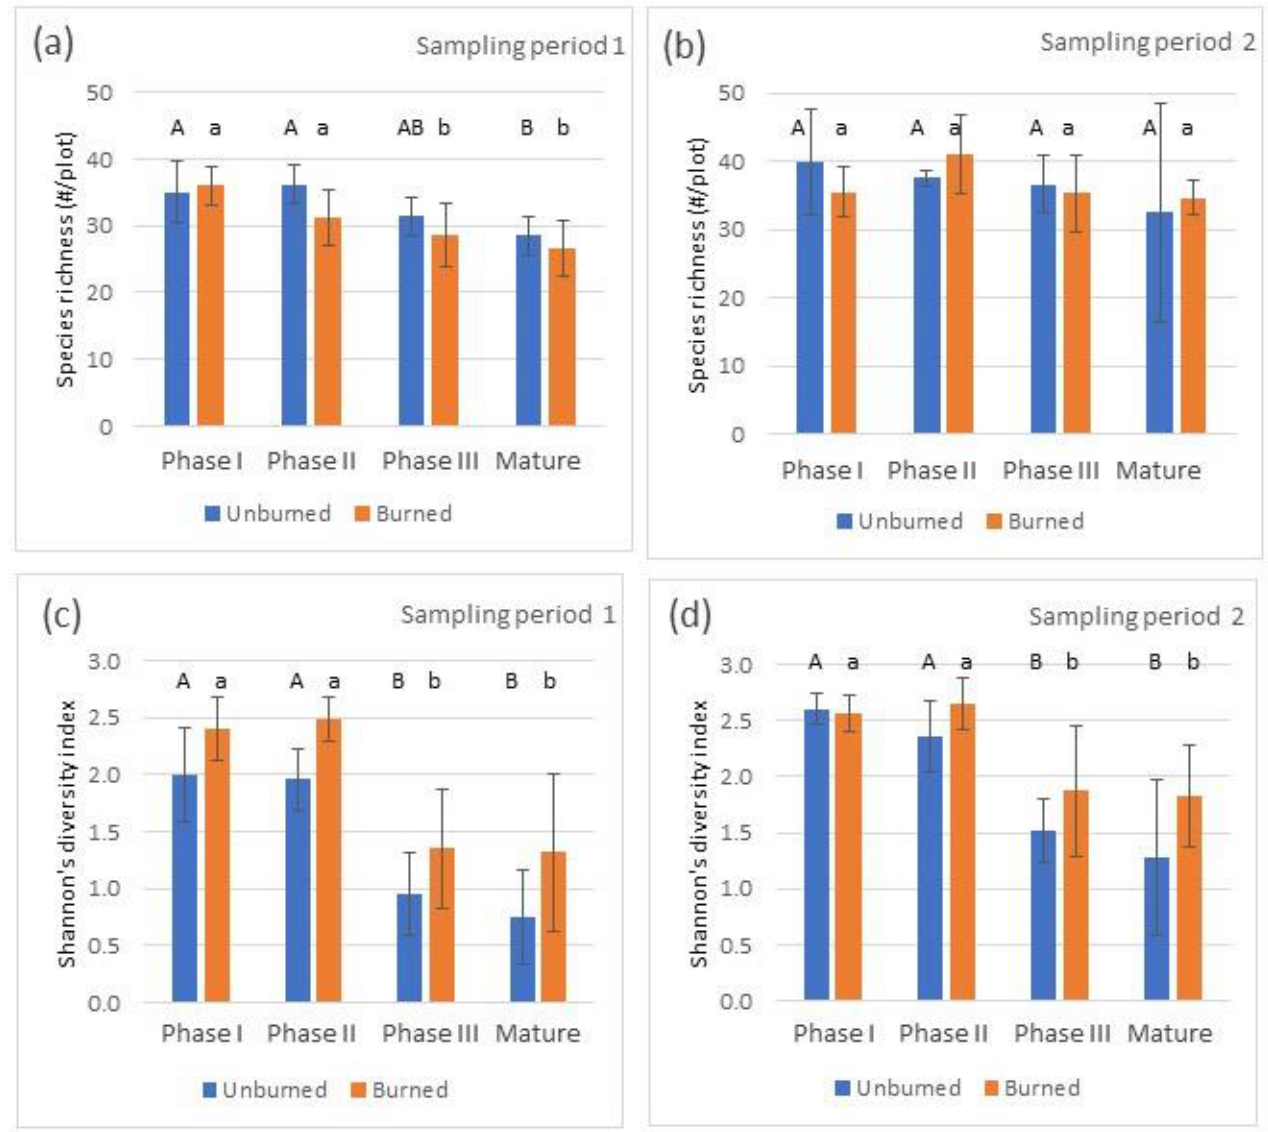
Figure 3. Species richness by woodland development phase in unburned and burned stands 5–6 years post-fire ( a ) and 12–13 years post-fire ( b ). Shannon’s Diversity Index (H’) by woodland development phase in unburned and burned plots 5–6 years post-fire ( c ) and 12–13 years post-fire ( d ). Error bars represent standard deviation between plots within the same woodland development phase. Capital letters A and B indicates statistical difference ( p < 0.05) between phases for unburned plots and lower-case a and b indicates difference between phases in burned plots. Bars with the same letter combination indicates there is no difference.